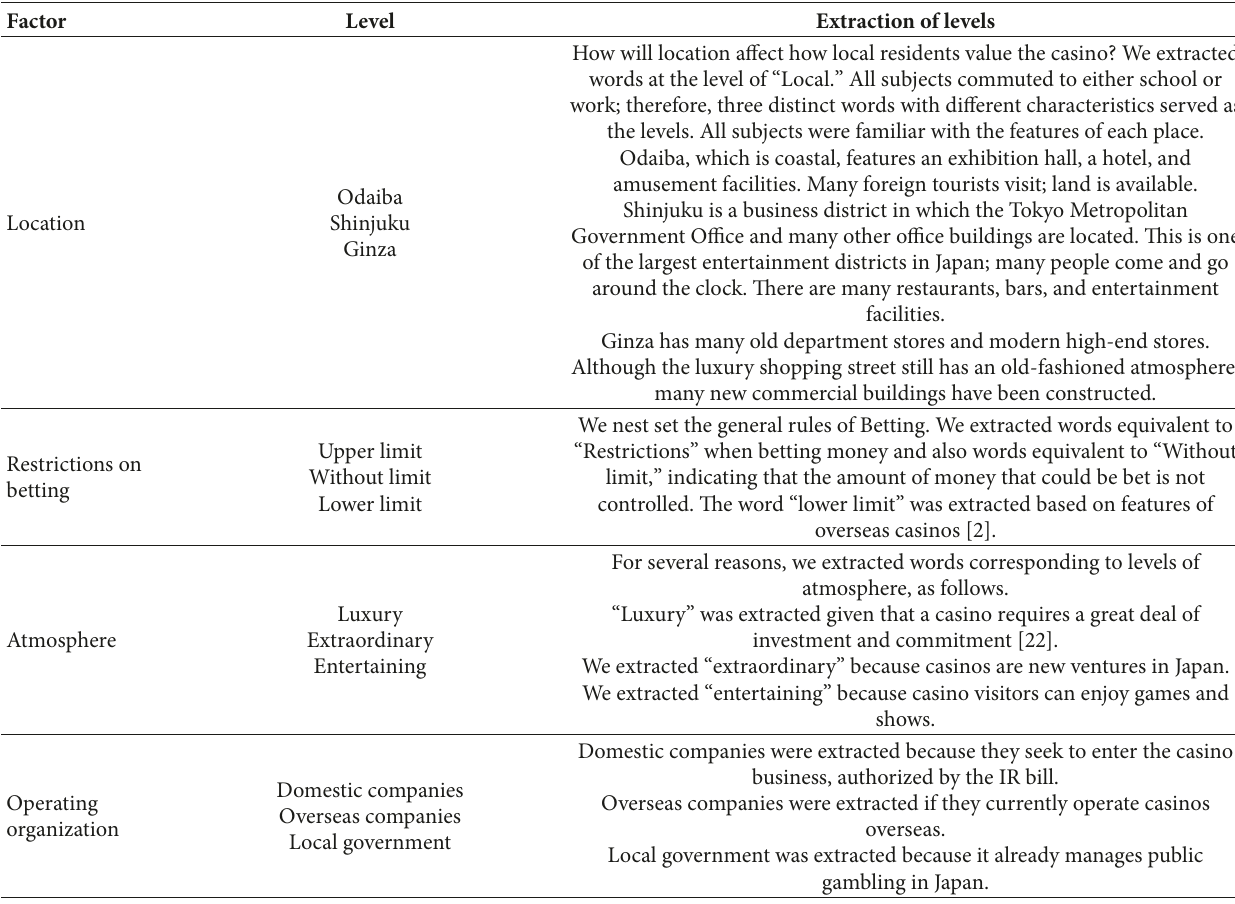
Table 2: Extraction protocol for words expressing